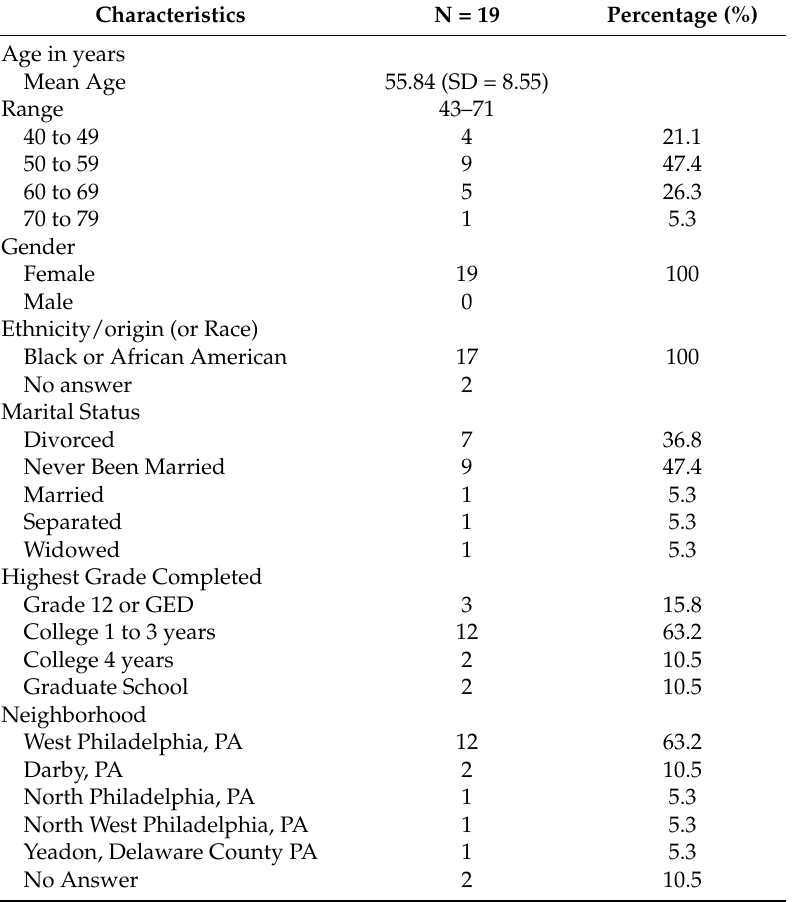
Table 2. Frequency Distribution of Selected Demographic Variables